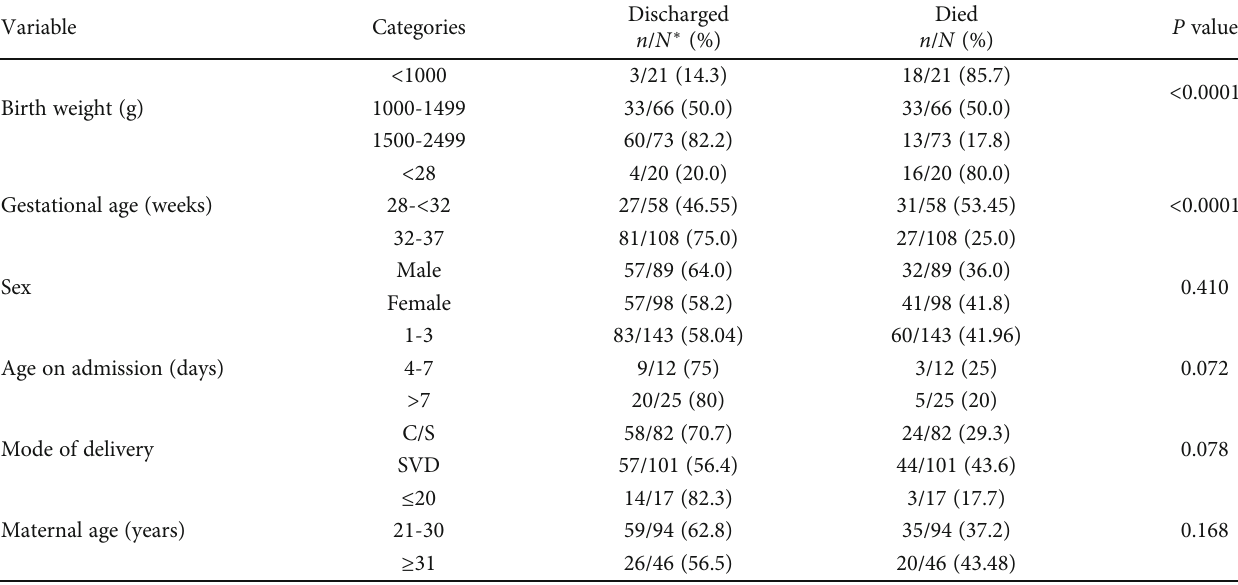
Table 3: Bivariate analysis of baseline maternal and neonatal characteristics at